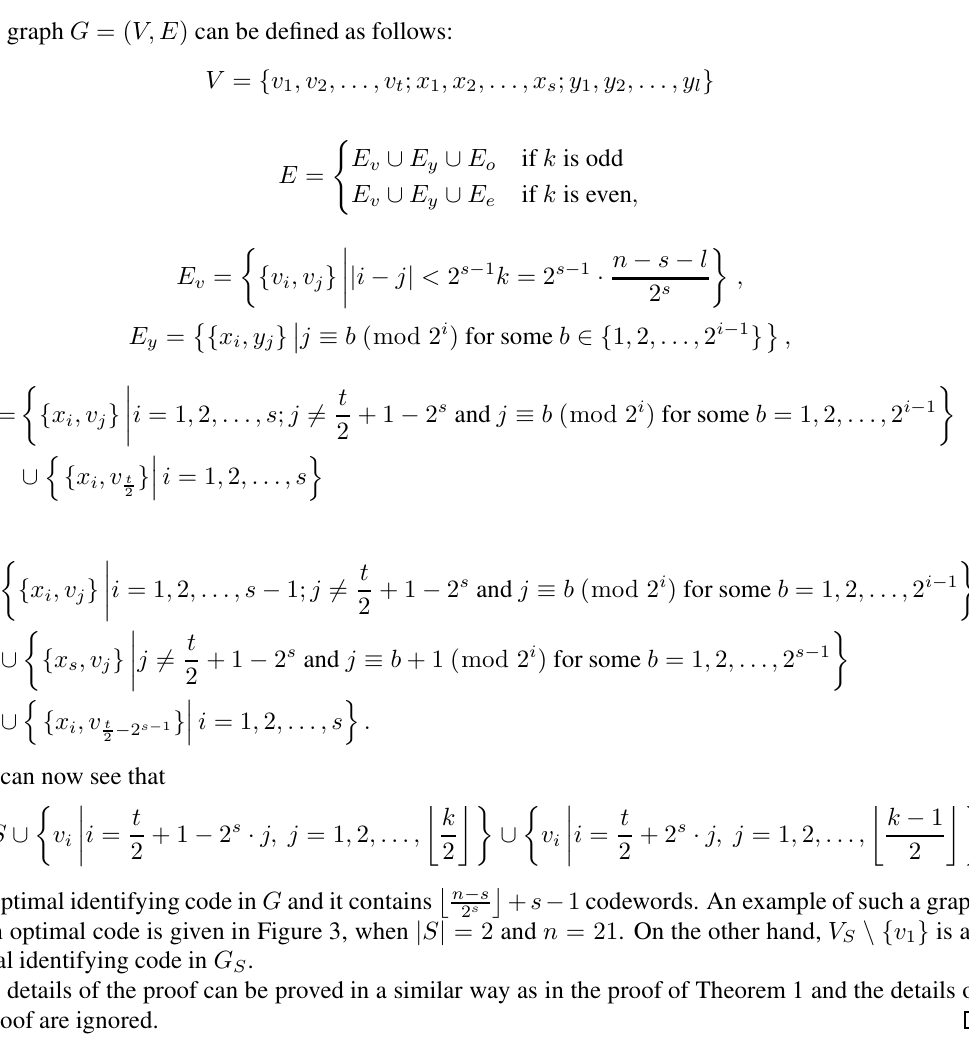
Fig. 3: A such graph G where γ ( G S ) − γ ( G ) is maximal when | S | = 2 and n = 21 . The black dots are an identifying code of G . Notice that all edges between the vertices in the path are not drawn in the